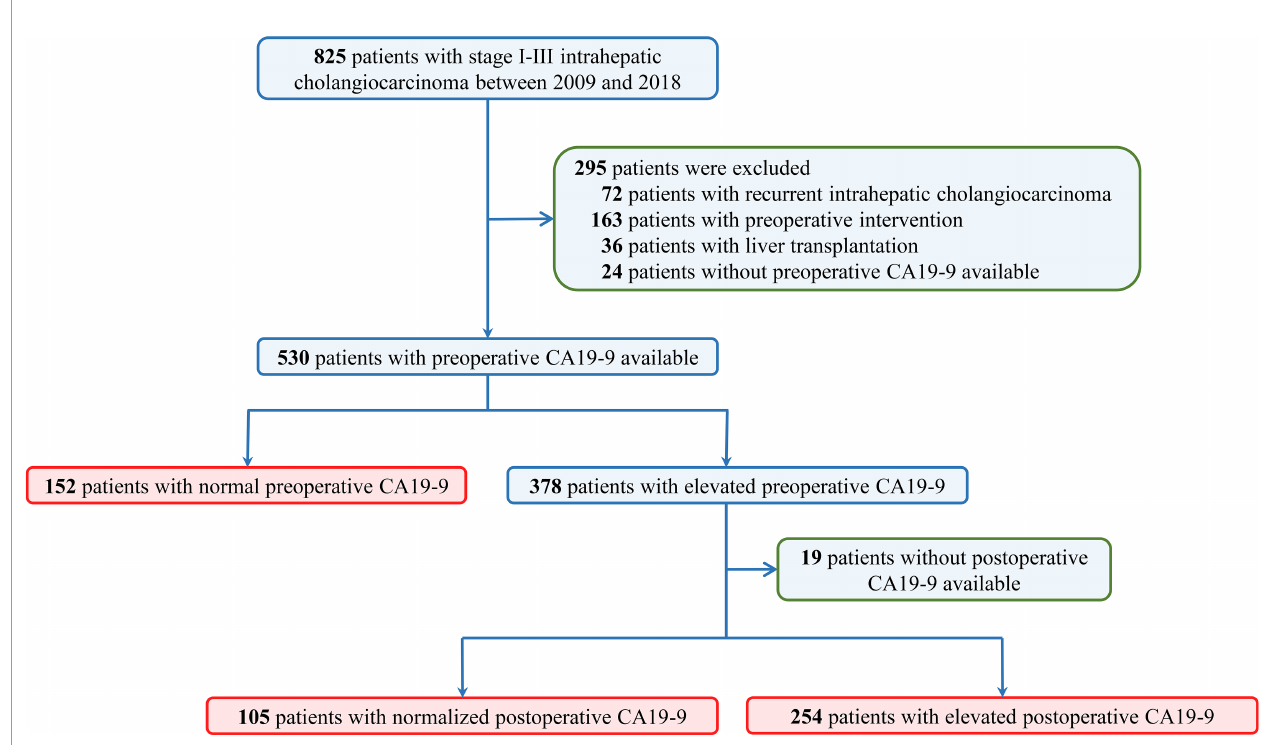
FIGURE 1 | Flow diagram of the study design. Datasets were queried for patients who underwent curative hepatectomy for stage I to III intrahepatic cholangiocarcinoma from January 2009 through December 2018 in three tertiary